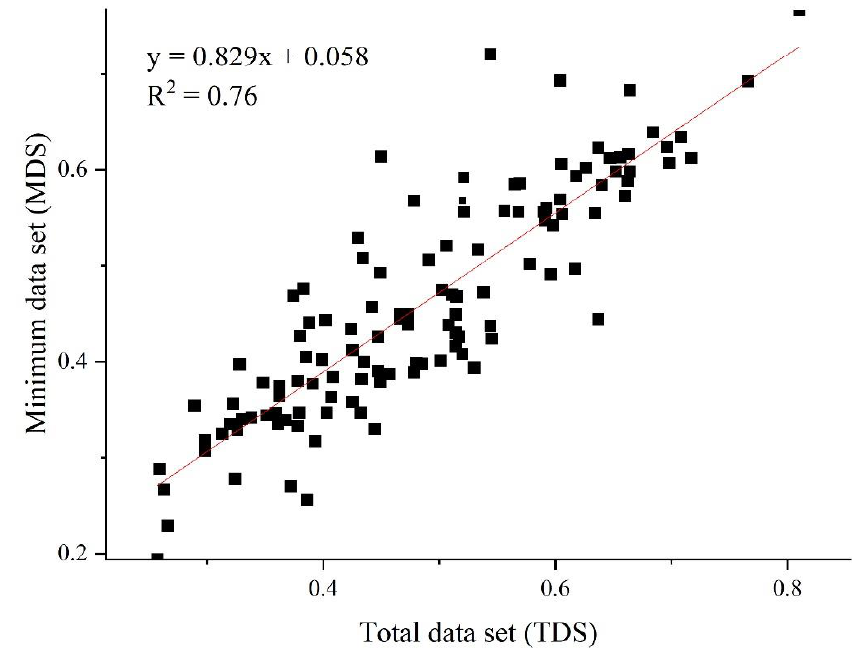
Figure 4. Soil quality linear fitting.